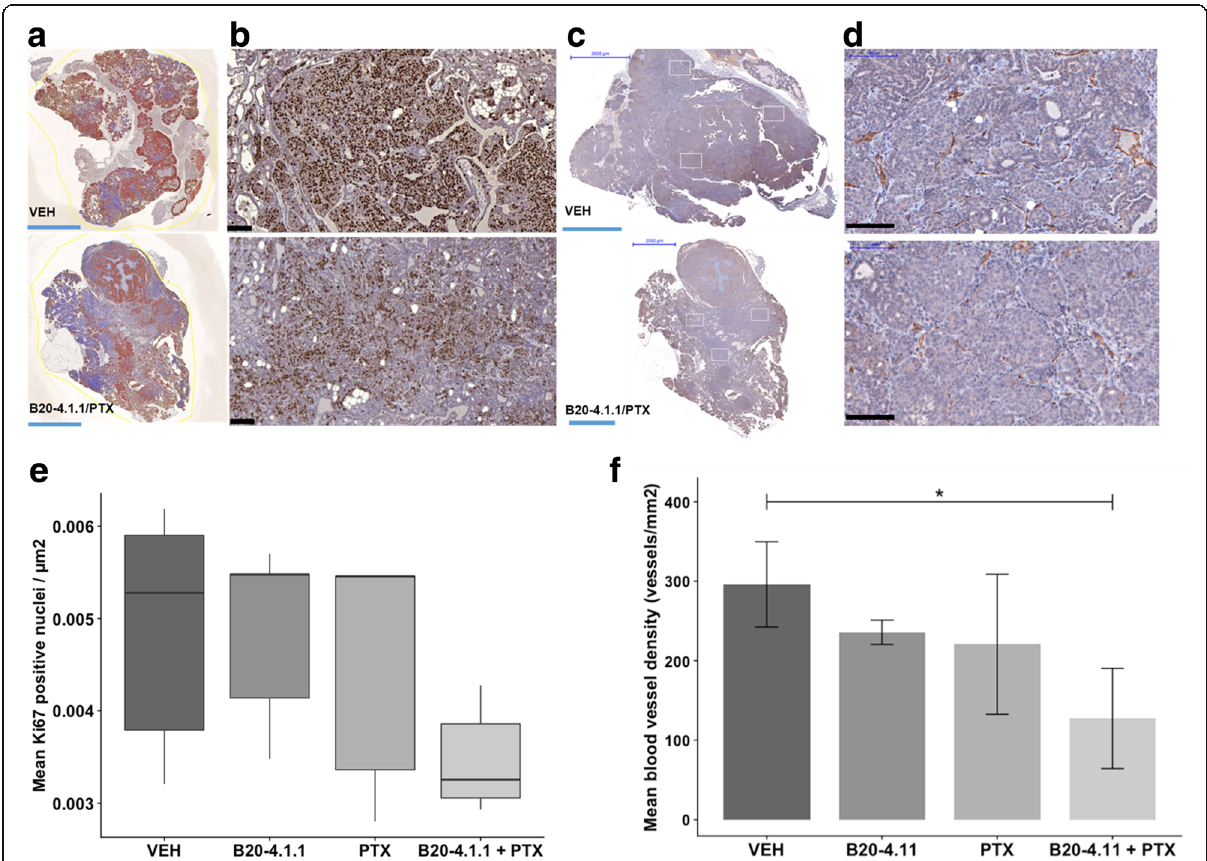
Fig. 4 Evaluation of treatment efficacy on PyMT mammary tumors ’ proliferation and angiogenesis. Immunostaining of a , b Ki67 and c , d CD31 expression in PyMT mammary tumors, treated with B20-4.1.1/PTX combination. The whole tumor cross-sections ( a , c ) and representative magnified tumor areas ( b , d ) shown for VEH (upper panel) and B20-4.1.1/PTX combinational treatment (lower panel). Ki67-positive signals within the tumors are shown in brown. The boxed areas indicate tumors “ hotspots ” with the highest density of microvessels, selected for quantification. Scale bars: blue = 20 mm; black = 100 μ m. e Quantitative assessment of mean Ki67-positive signal per micrometer of tumor viable area in each sample ( n =5 in each treatment group). The Ki67 proliferation index was considerably low in B20-4.1.1/PTX combination group (the mean value, 0.0035) in comparison to the VEH (0.0049), B20-4.1.1 (0.0048), or PTX (0.0045) monotherapy groups; however, no statistically significant difference was observed (Kruskal-Wallis test, p >0.05). A box plot displays the range of variation of the Ki67 proliferation index for each treatment group (the horizontal lines indicate the median value). f Tumor vessel density, in vessels/ μ m 2 . A significant difference was found between the VEH and B20-4.1.1/PTX groups (the mean values 296.2 and 127.2 vessels/ μ m 2 , respectively), but not between the VEH and B20-4.1.1 or PTX groups (the mean values 236 and 220.7 vessels/ μ m 2 , respectively; Dunn ’ s multiple comparisons test, * p <0.05). Error bars represent standard